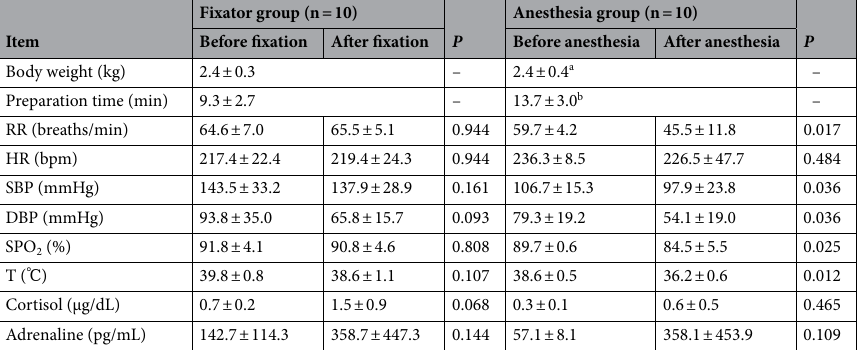
Table 1. Vital sign and stress hormones changes of the two groups ( SBP: Systolic blood pressure; DBP: Diastolic blood pressure; T: Body temperature. a Compared with the fixator group, P = 0.976. b Compared with the fixator group, P =